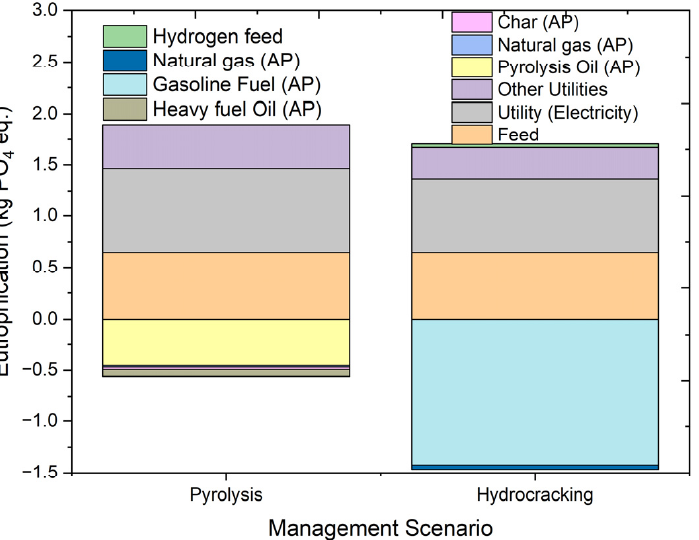
Figure 17. Impact assessment of pyrolysis and hydrocracking for the management of waste HDPE on eutrophication potential (kg PO 4